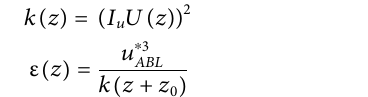
Frontiers in Earth Science |